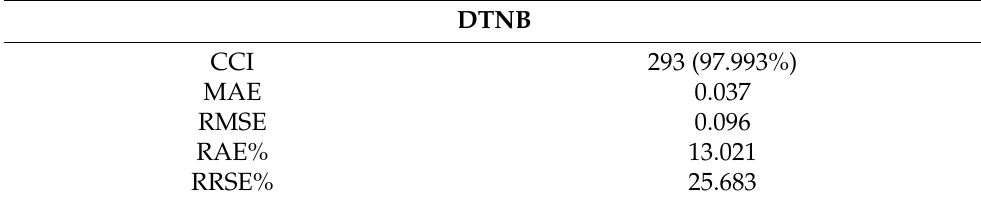
Table 15. CCI and Error Rates details achieved via DTNB.